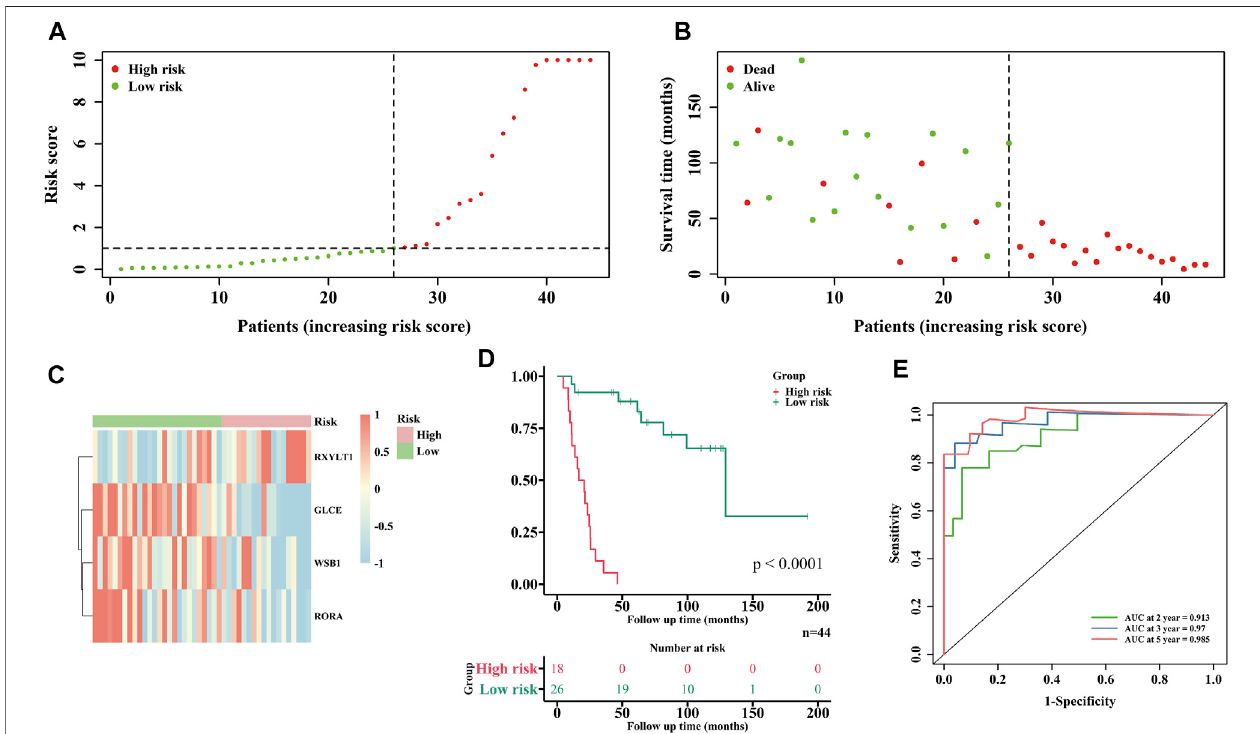
FIGURE 3 | Construction of prognostic signature in the GEO cohort. (A) Distribution of each EWS patient according to the risk score. (B) Survival state-related scatterplot of EWS patients. (C) Heatmap of 4 HRGs expressions in two risk groups. (D) KM curves of low- and high-risk groups. (E) Evaluation of the prognostic signature by ROC